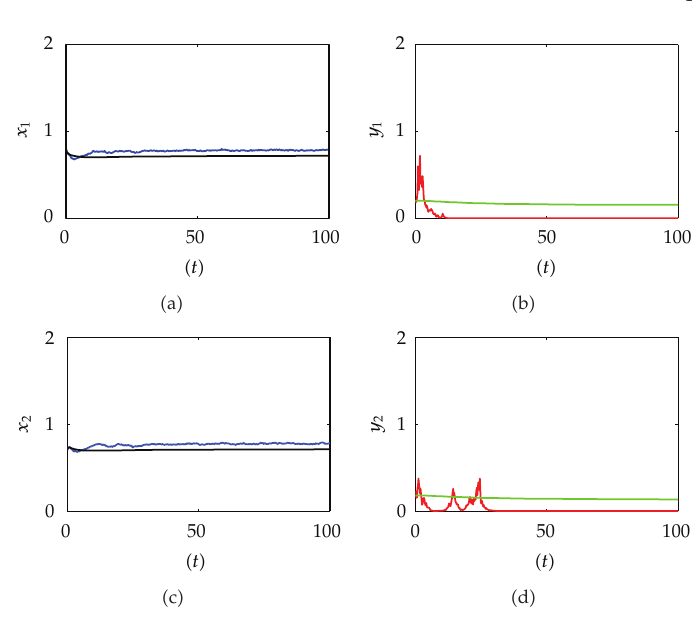
Figure 8: The solution of stochastic system compared to the deterministic system: σ 11 (cid:5) σ 12 (cid:5) 0 . 01 ,σ 21 (cid:5) 0 . 8 ,σ 22 (cid:5) 0 . 7. The predator population su ff er the large white noise and then extinction. The blue and red lines represent the solutions of system (cid:2) 5.1 (cid:3) , and the black and green lines represent the solutions of corresponding undisturb